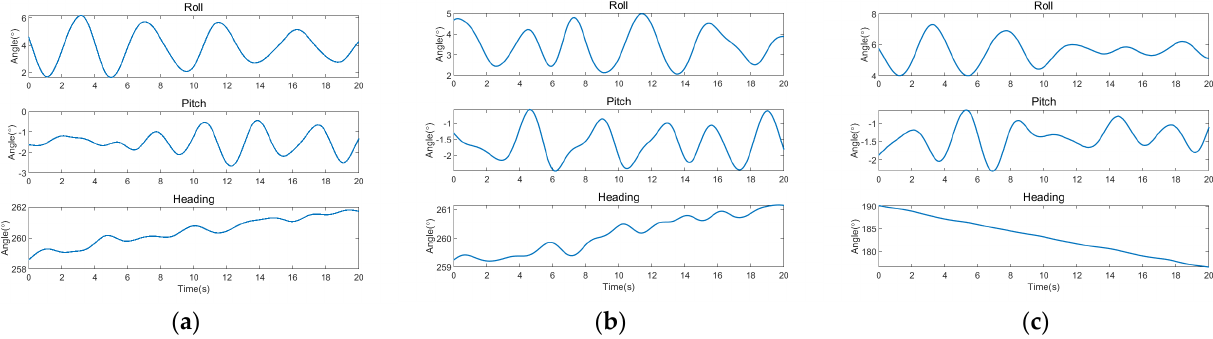
Figure 24. The measured ship attitude angles with a duration of 20 s. ( a ) A drifting ship in the unanchored state; ( b ) a drifting ship in the anchored state; ( c ) a moving ship in the navigating state.